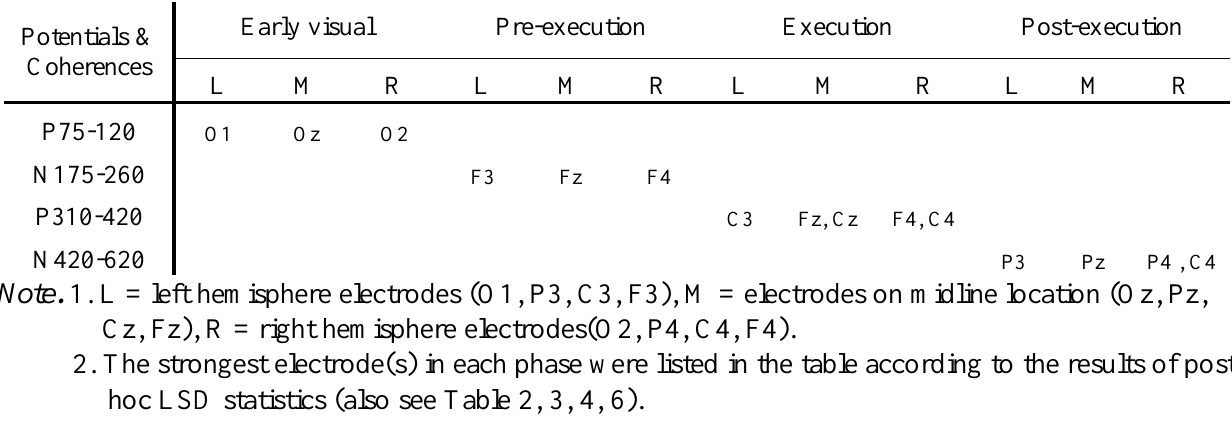
Table 8. Summarized major localized features of the brain potential